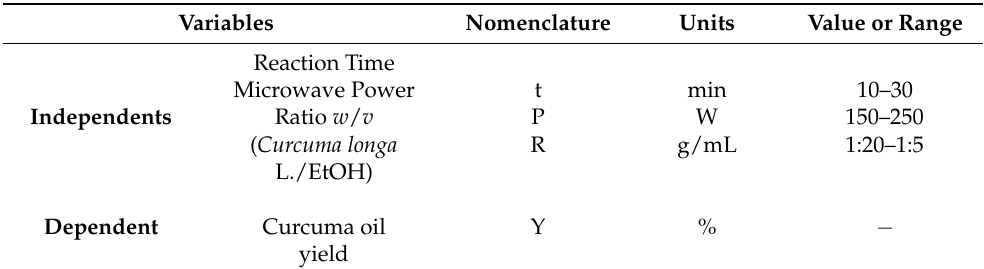
Table 6. List of the experimental variables involved in the microwave-assisted extraction of Curcuma longa L.